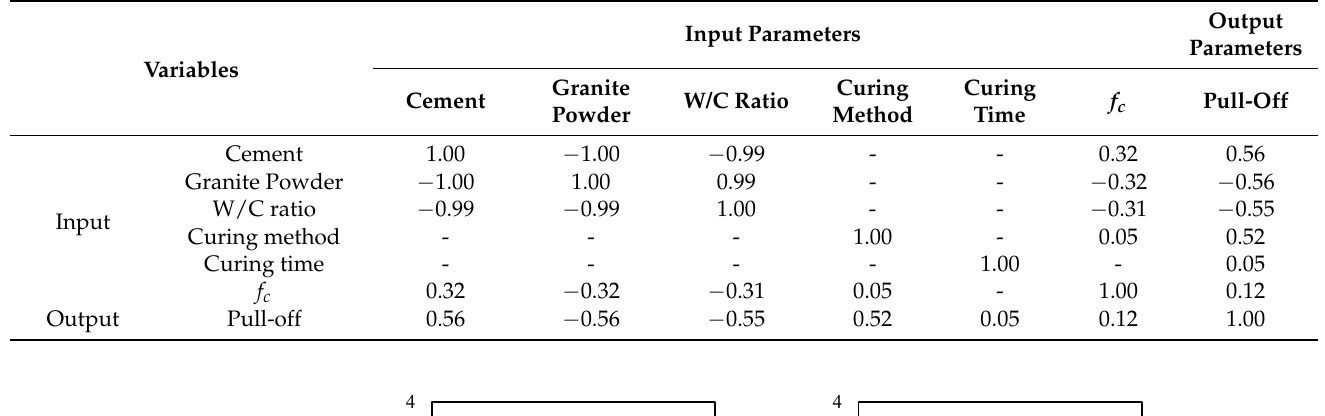
Table 3. Correlation matrix of the input and output variables.